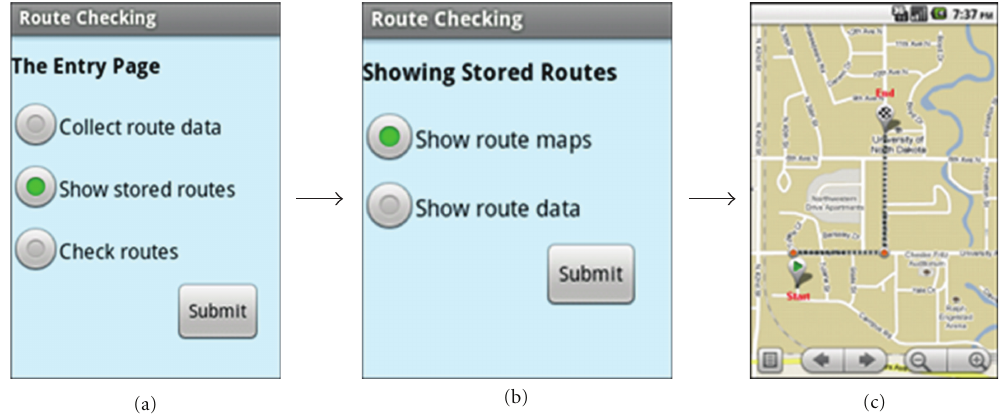
Figure 8: (a) The system entry page, (b) the page of showing stored routes, and (c) an example of a stored